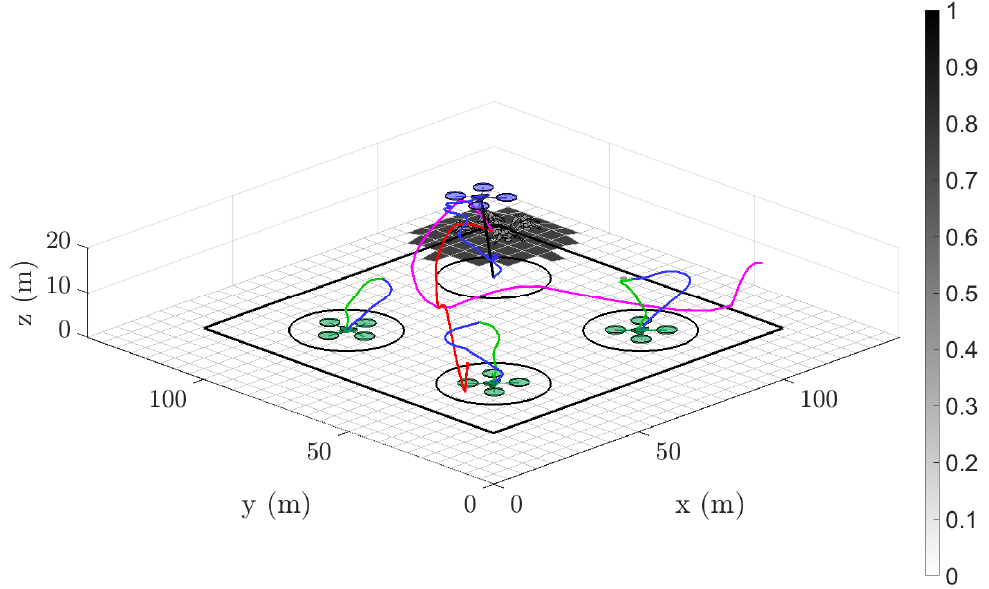
Figure A7. Double-target scenarios—sample simulation 3D trajectory by t = 79 s, E reserve = 444 J for both target flocks. Regions of maximum energy expenditure correlate to high acceleration areas such as take-offs and landings.